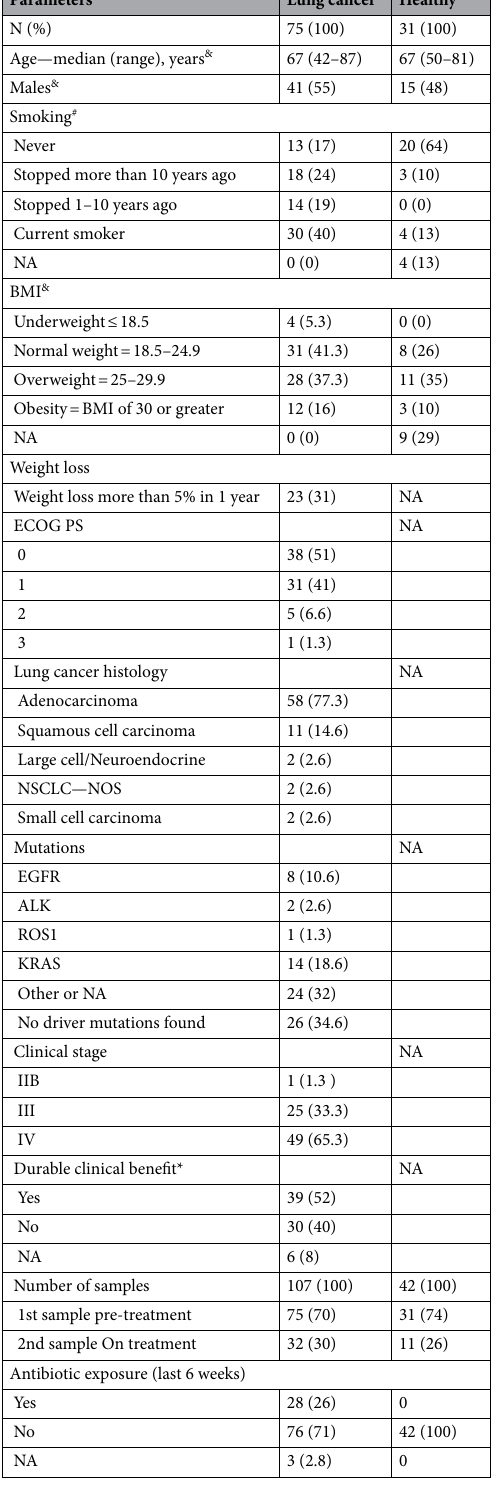
Table 1. Cohort characteristics. All numbers indicate N (%) besides age data. & P-value